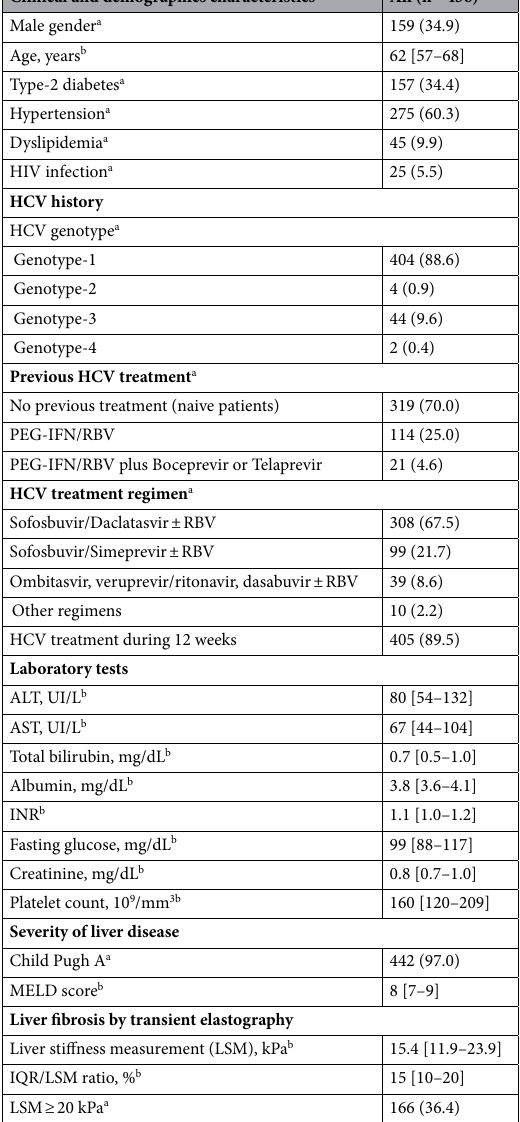
Table 1. Characteristics of patients included in the study before HCV treatment (at baseline). Data expressed as a n (%) or b median [IQR]. ALT alanine aminotransferase, AST aspartate aminotransferase, INR international normalized ratio, PEG-IFN pegylated interferon, RBV ribavirin. Missing data (n): type-2 diabetes (2), hypertension (2), dyslipidemia (9), HCV genotype (1), previous HCV treatment (1), duration of HCV treatment (1), ALT (19), AST (15), total bilirubin (35), albumin (60), INR (68), fasting glucose (34), creatinine (32), platelet count